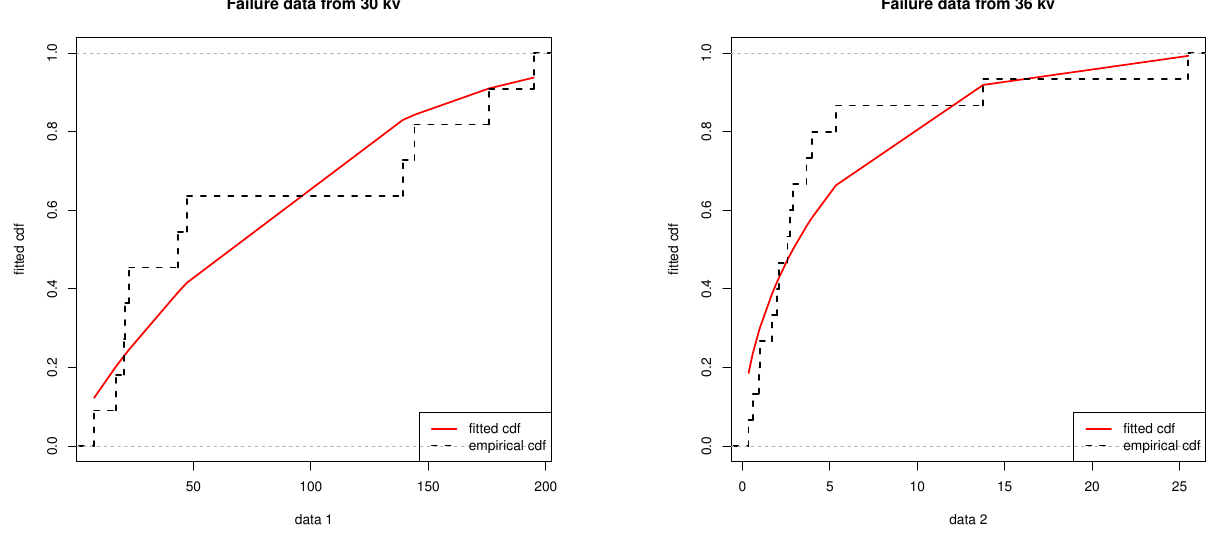
Figure 9. The empirical cumulative distribution function and the fitted cumulative distribution function for failure data under stress levels s 1 = 30 kV (Left, data 1) and s 2 = 36 kV (Right, data